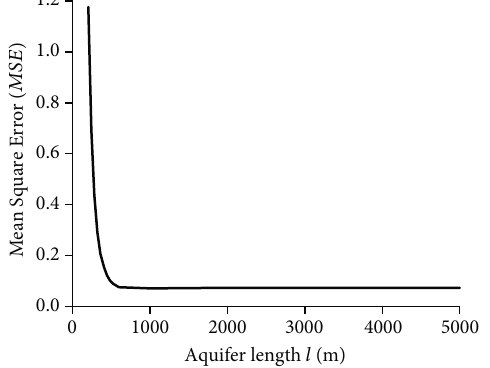
Figure 11: Accuracy of simulation results of di ff erent aquifer